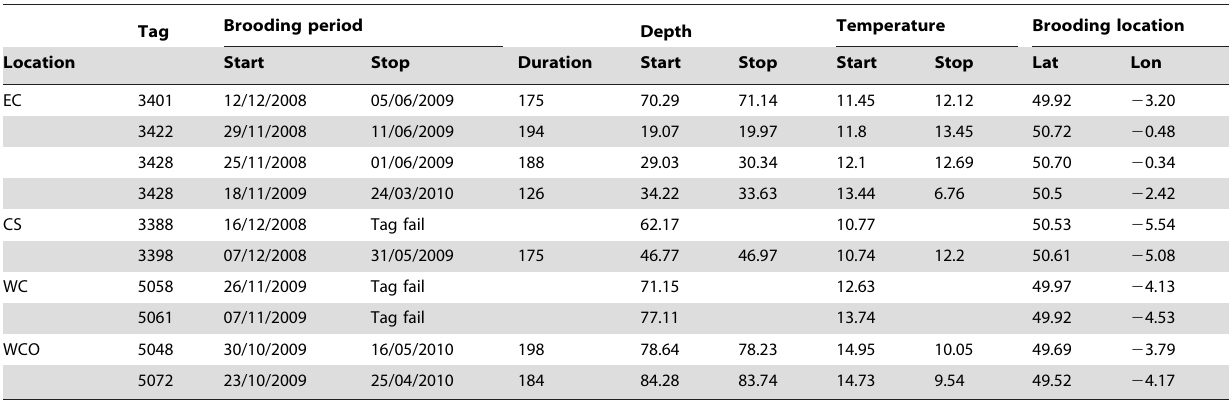
Table 2. Metrics of egg incubation.